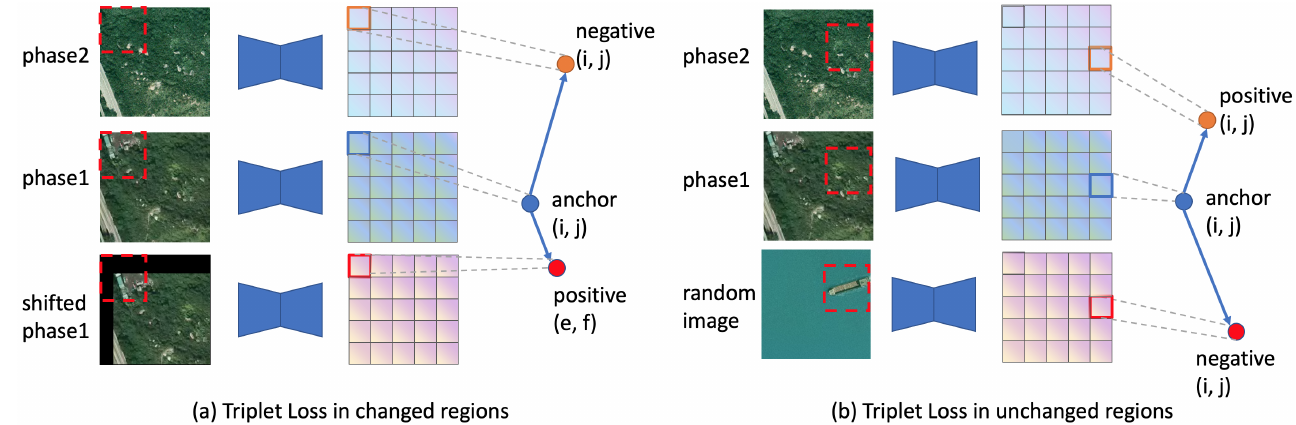
Figure 3. The two sources of triplet pairs of the proposed